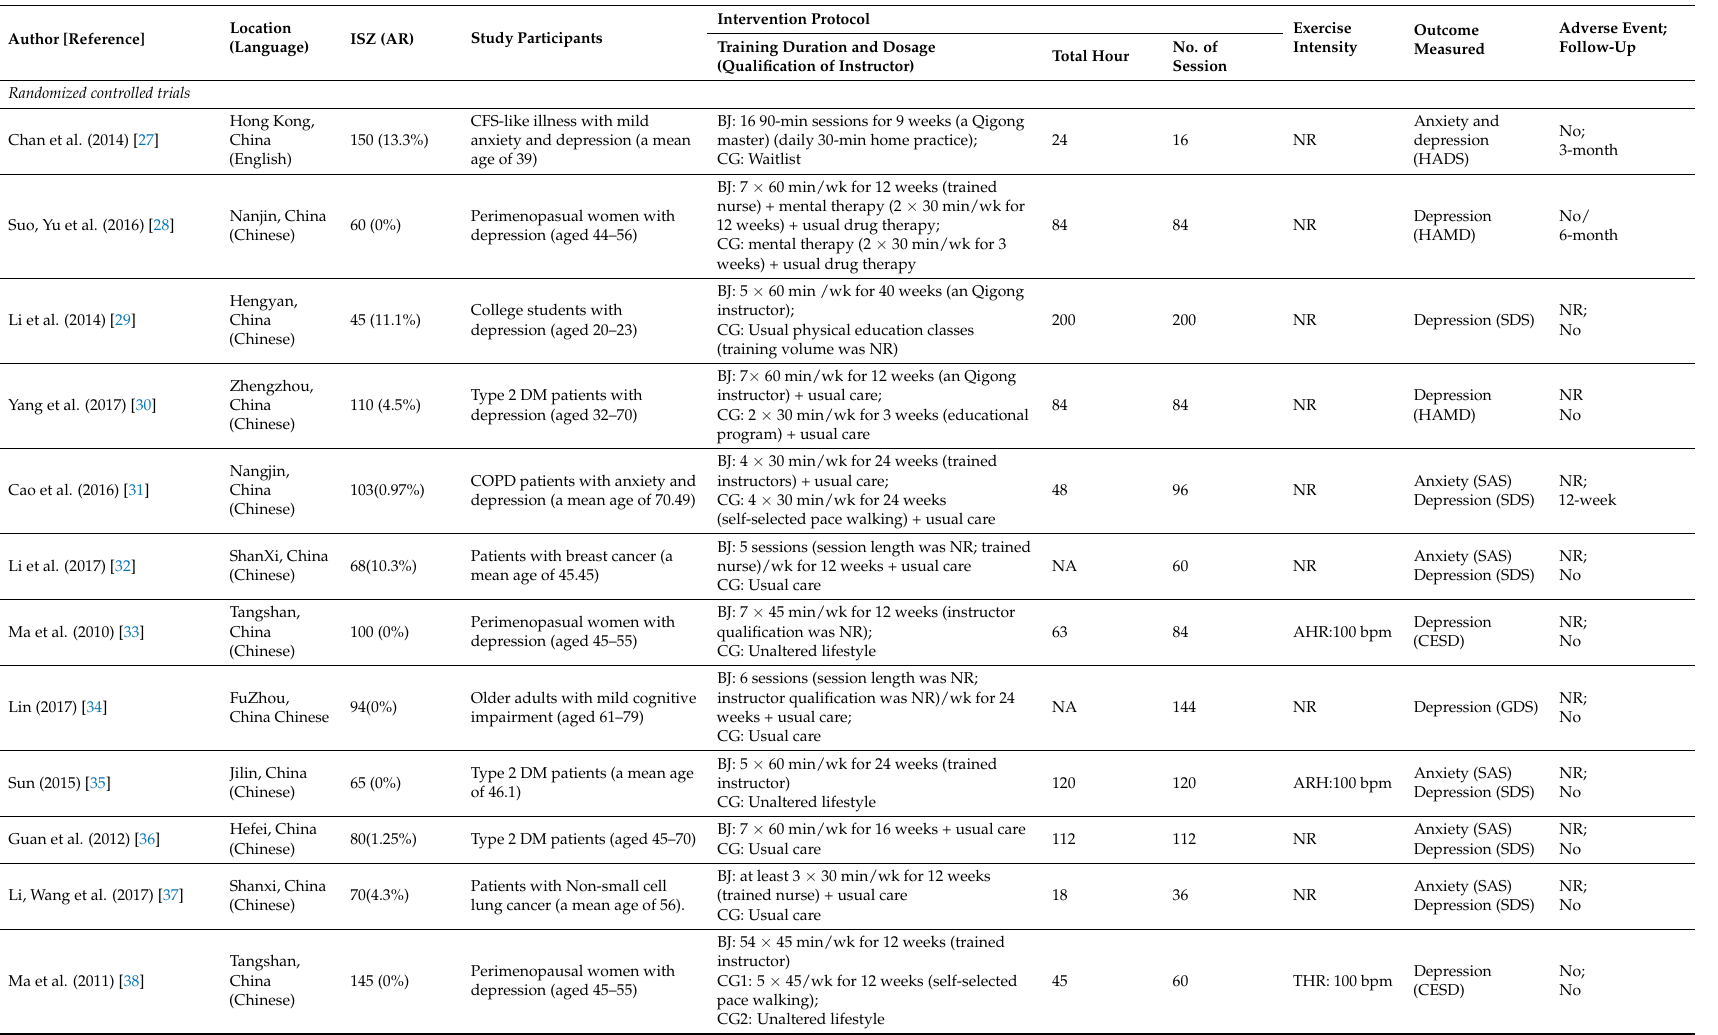
Table 1. Summary table relating to